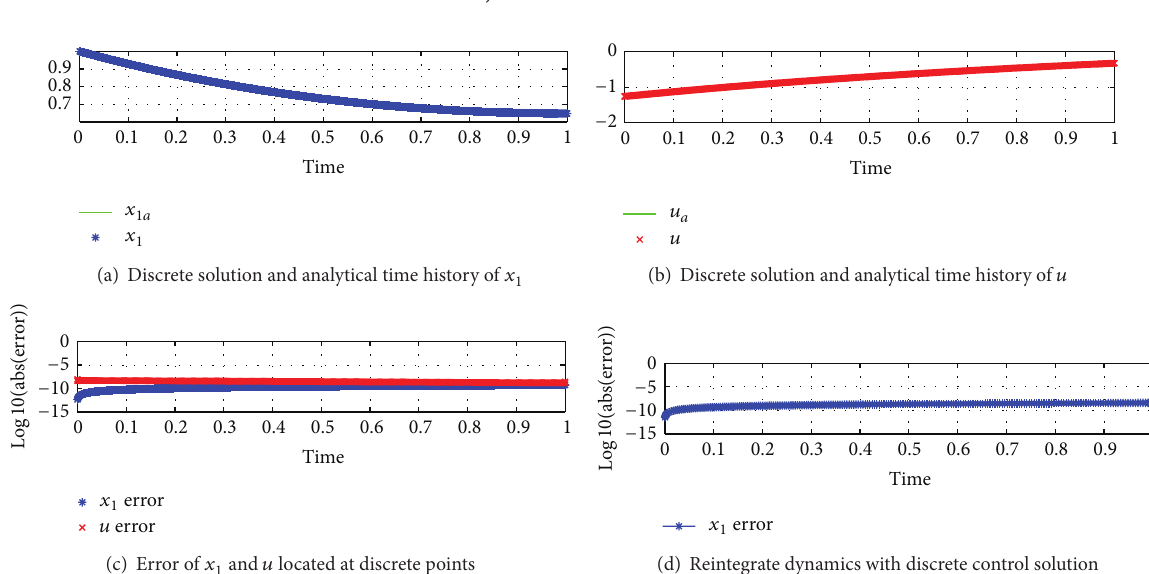
Figure 10: Simulation results of Example 1, 5000